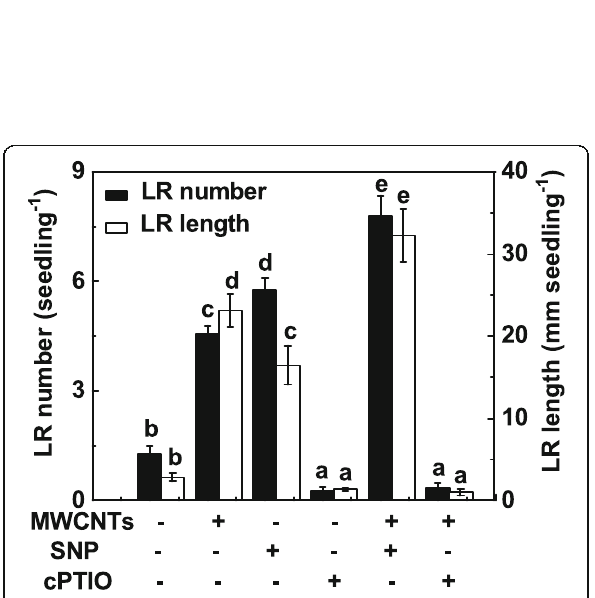
Fig. 4 MWCNT-induced LR formation was sensitive to the removal of endogenous NO with cPTIO, its scavenger. Three-day-old tomato seedlings were treated with distilled water, 5 mg/mL MWCNT, 0.1 mM SNP, 0.2 mM cPTIO, alone or in combination for 3 days. Afterwards, the number and length of emerged lateral root (> 1 mm) per seedling were then determined. There were 30 (10 × 3) plants in three biological replicates, and the experiments were conducted for 3 times. Data are the means± SE. Within each set of experiments, bars denoted by the same letter did not differ significantly at p < 0.05 level according to Duncan ’ s multiple